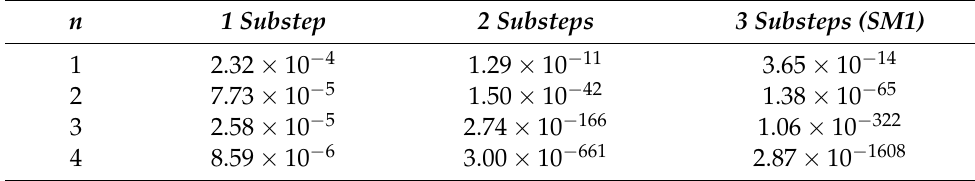
Table 4. || v n − v ∗ || for algorithm SM1.